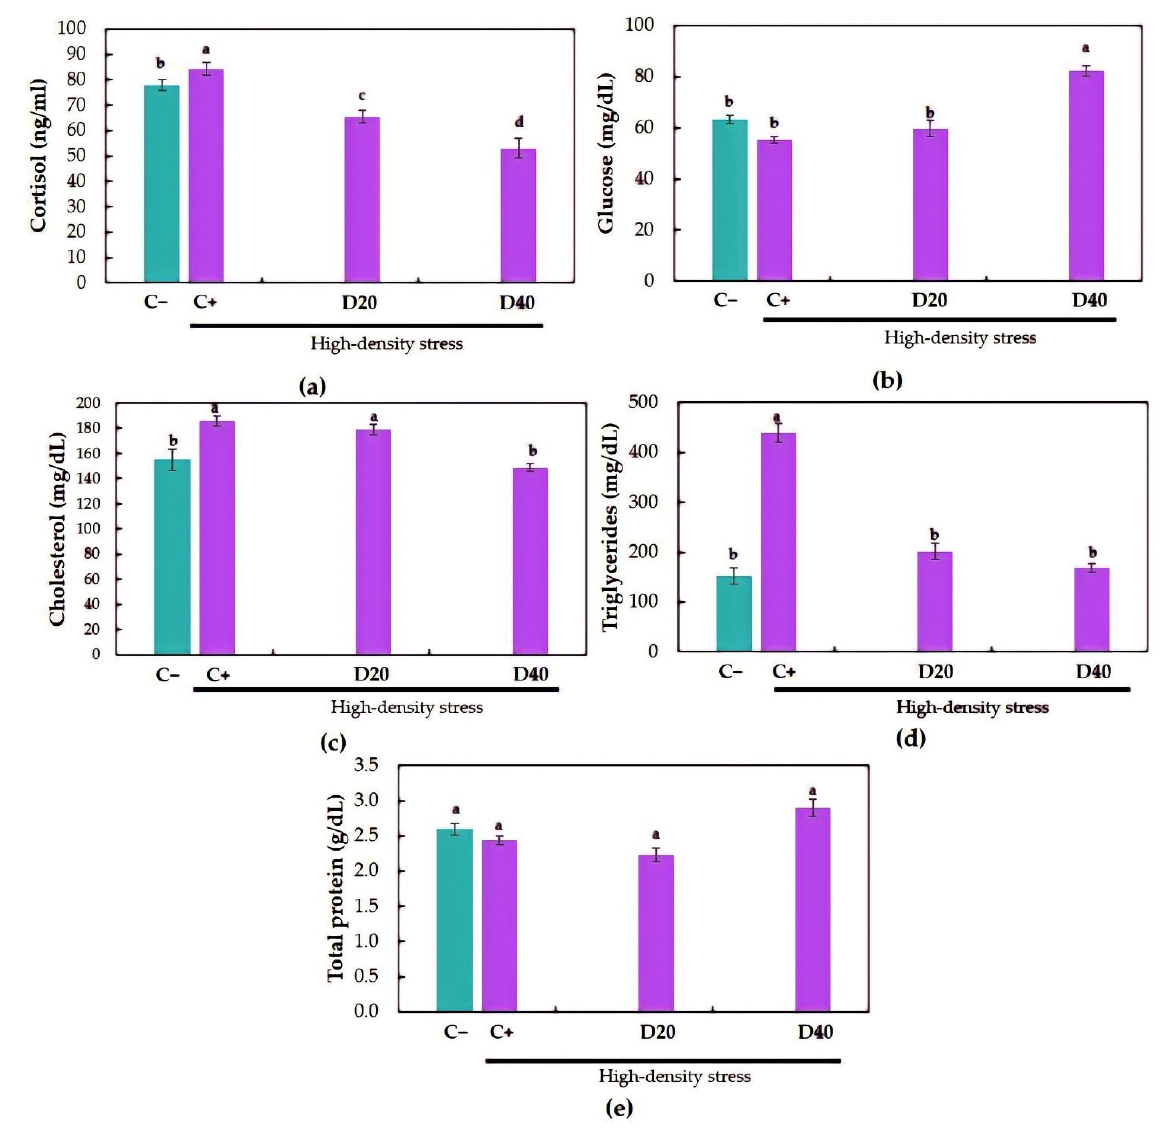
Figure 2. Effect of dietary agavin on blood metabolites of Nile tilapia ( O. niloticus ) after 20 days under high rearing density (63 kg/m 3 ). ( a ) Cortisol; ( b ) glucose; ( c ) cholesterol; ( d ) triglycerides; and ( e ) total blood protein. C − , control without high-density stress; C+, control under high-density stress; D20, experimental diet supplemented with 20 g/kg agavin under high-density stress; D40, experimental diet supplemented with 40 g/kg agavin under high-density stress. Data from five biological replicates are shown as the mean ± SE values. Different letters correspond to significant differences ( p < 0.05) according to Tukey’s HSD test ( n = 5). Table 5. Hepatic antioxidant response to Nile tilapia fed for 80 days under low-density conditions.